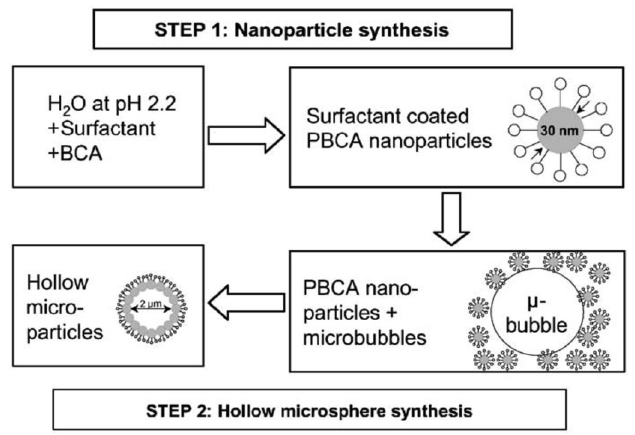
FIGURE 1 - Scheme of the two-step process for the synthesis of gas-filled hollow microspheres (Schmidt, Roessling,